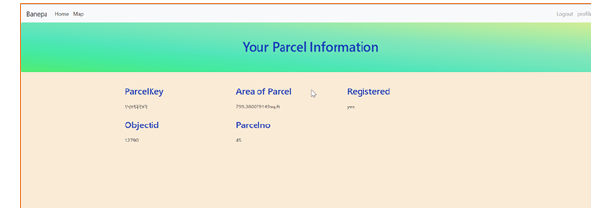
Figure 8. Adding/ Modifying parcel data to the database